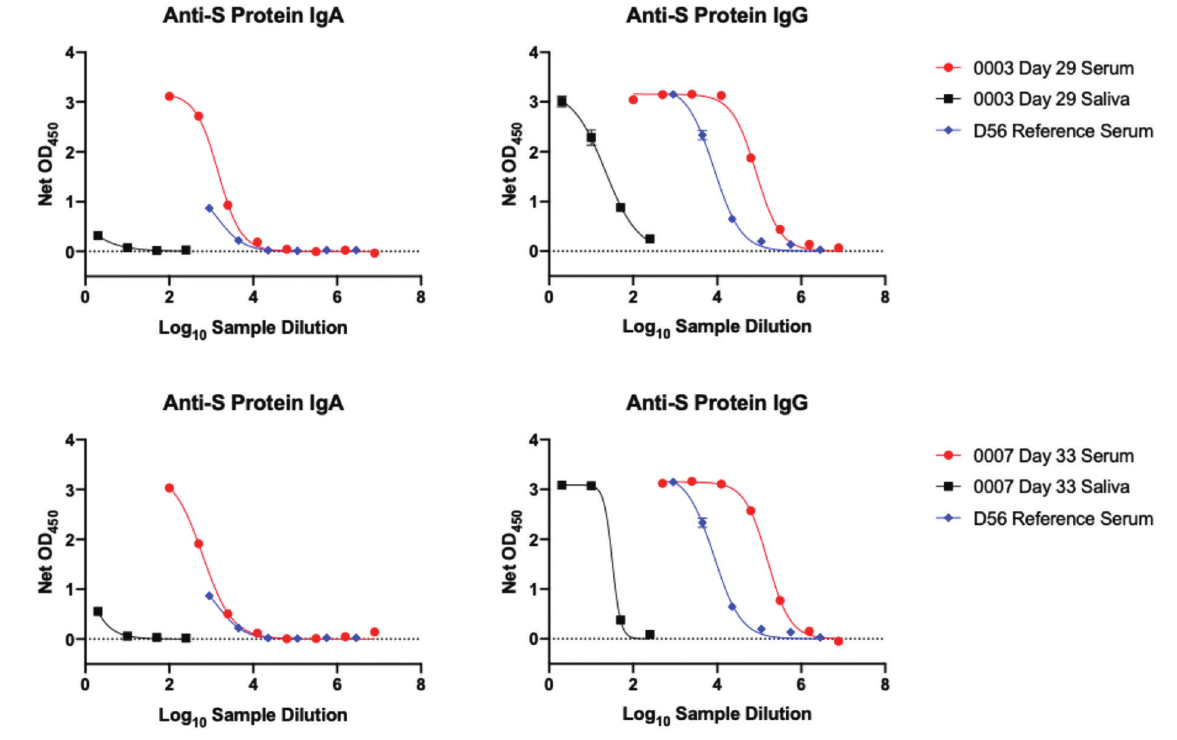
Figure 5. Relative antibody reactivities with S-protein in saliva and sera. A reference serum from a SARS- CoV-2 infected person (D56, not part of the NYP-WELCOME cohort; in blue) and serum (in red) and saliva (in black) samples from 2 recipients of 2 doses of the Pfizer vaccine (0003, day-29, top row; 0007, day-33, bottom row) were titrated under the conditions of the ELISA used to detect IgA and IgG in saliva. The displacement of the serum and saliva titration curves suggest that the S-protein IgA and IgG end- point titers in saliva are ~1000-fold and ~10,000-fold lower than in sera,